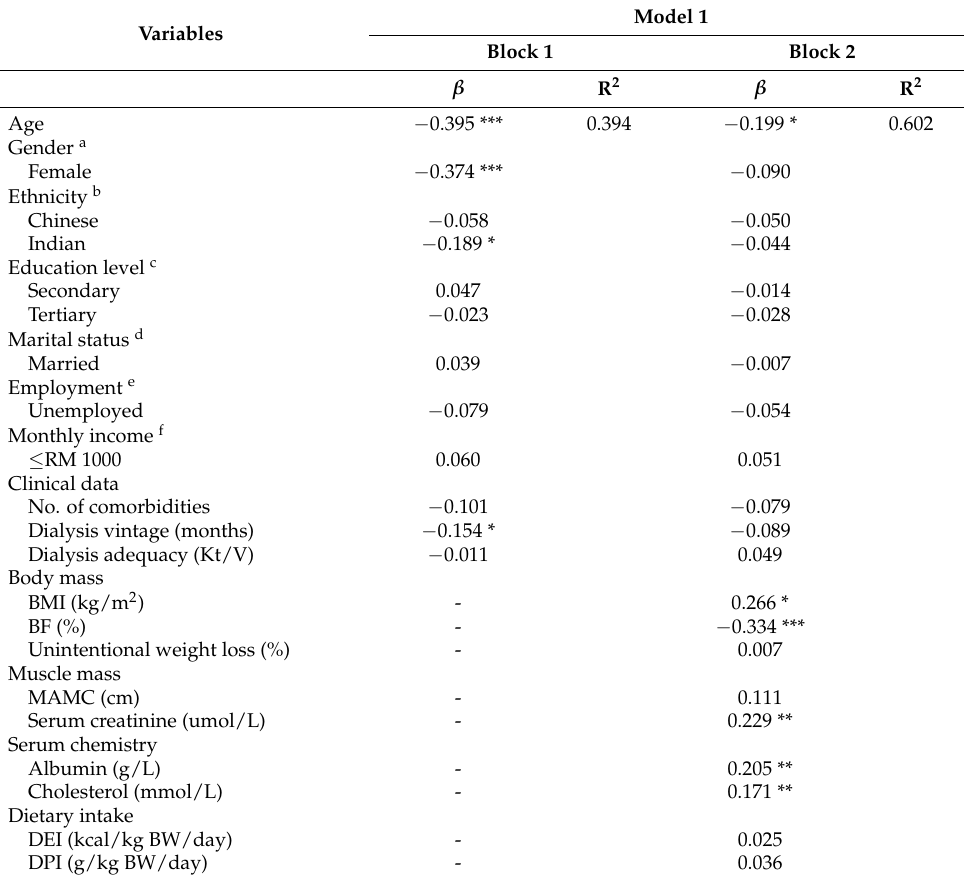
Table 2. Predictors of PhA in HD Patients ( n =